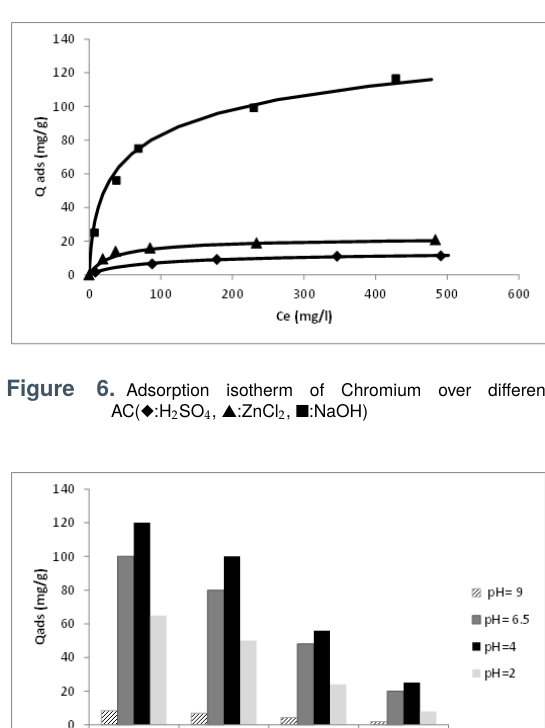
Figure 7. Effect of solution pH on extent of Chromium VI adsorption.